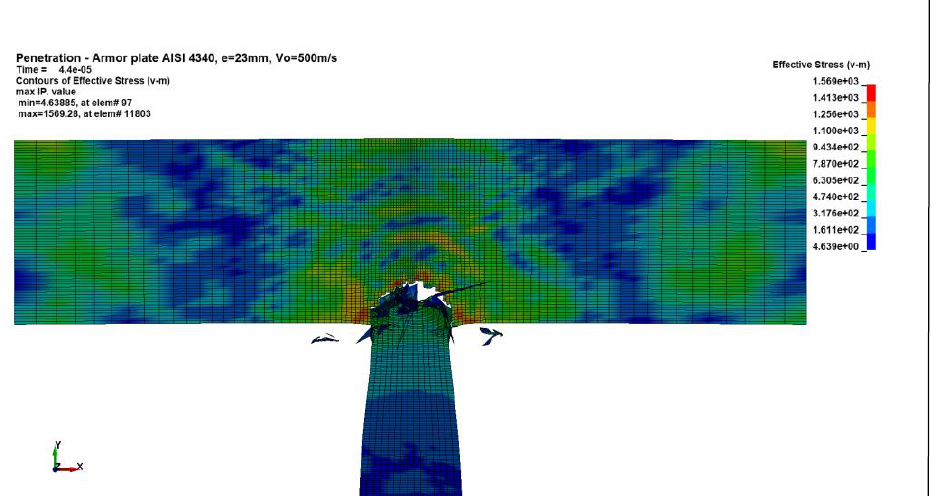
Figure 11 – Von Misses equivalent stress, time of analysis 0.04 ms – Model 2 Рис. 11 – Von Misses эквивалентное напряжение, время анализа 0.04 ms – Модель 2 Слика 11 – Von Misses-ов еквивалентни напон, време анализе 0,04 ms – модел 2